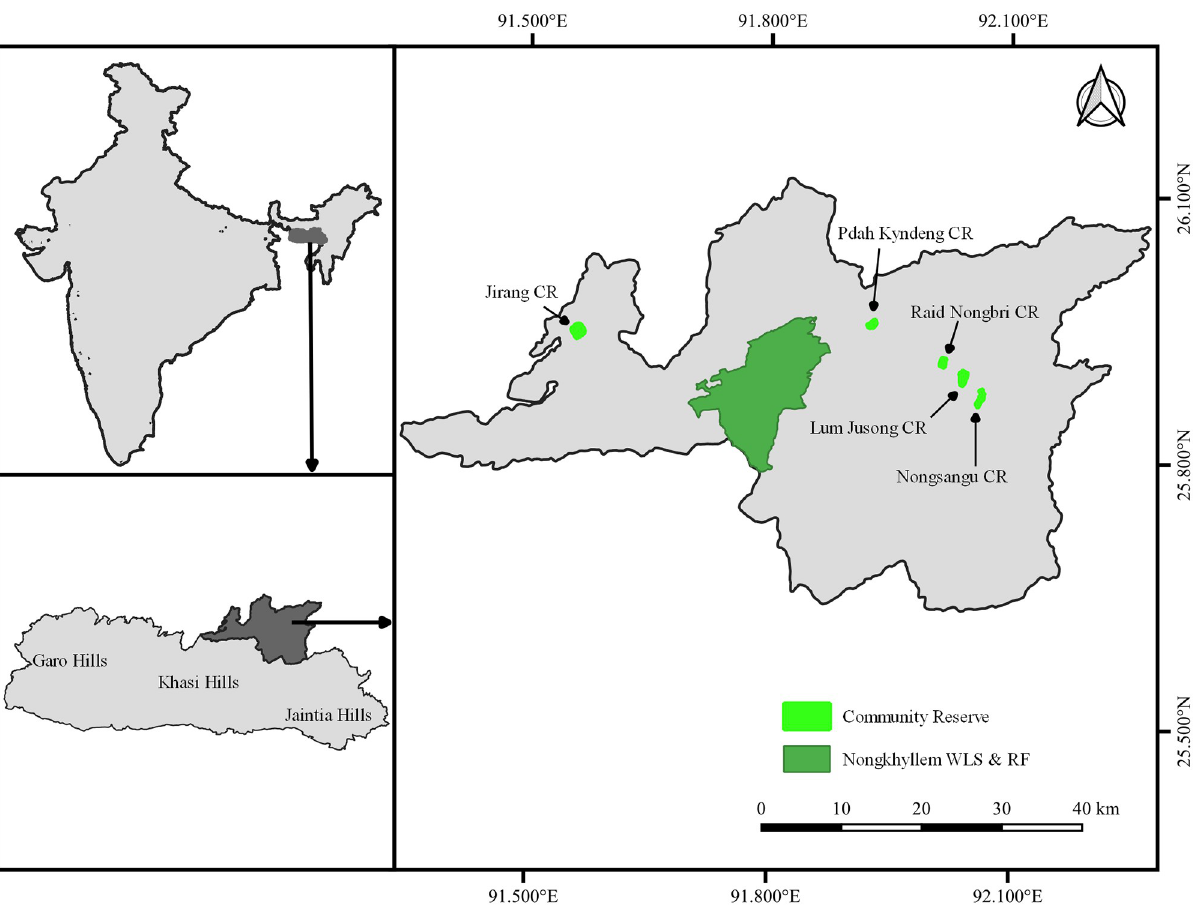
Fig 1. Community reserves surveyed in Ri Bhoi district of Meghalaya. Republished from GADM database (https://gadm.org/) under a CC BY license, with permission from Global Administrative Areas (GADM), original copyright 2012.